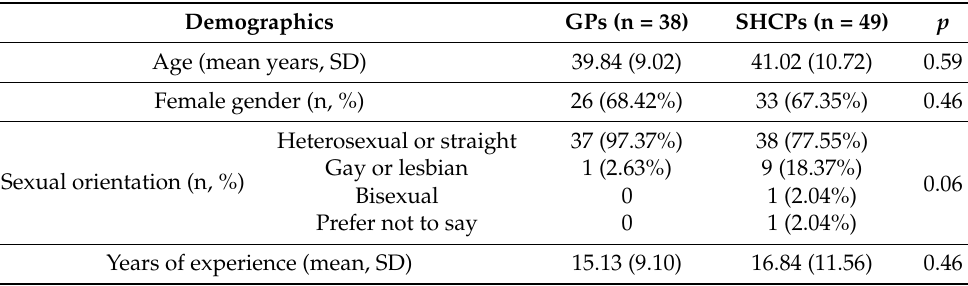
Table 1. Survey participant